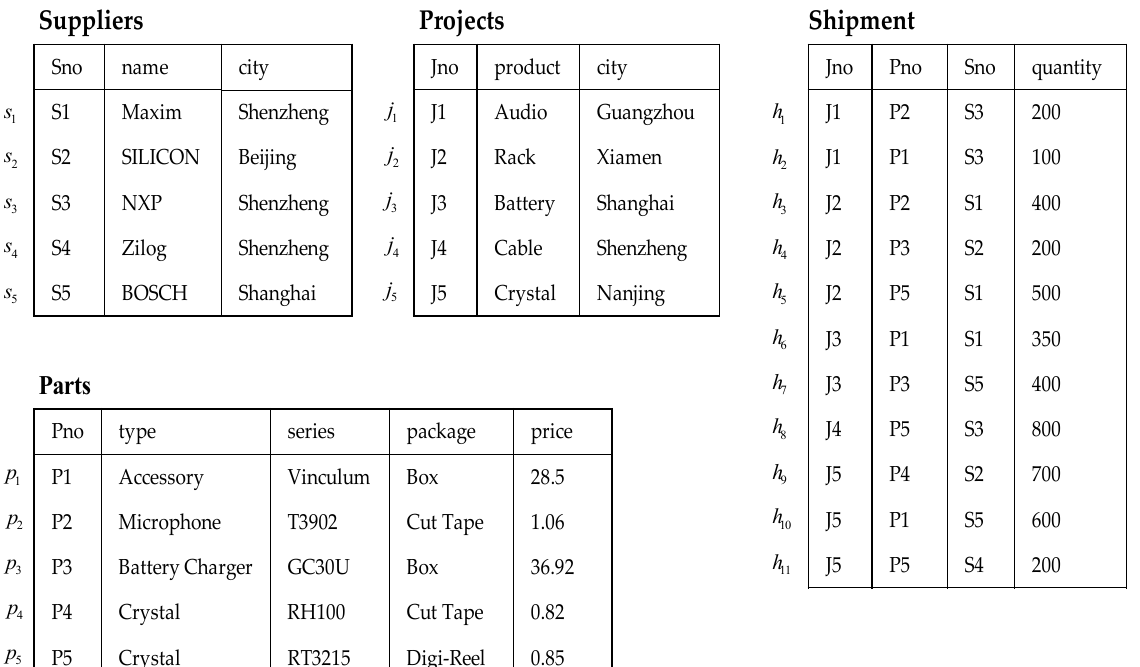
Figure 1. A sample database. Suppliers, parts, and projects are uniquely identified by supplier number (Sno), part number (Pno), and project number (Jno), respectively. The shipment relation stores the number of parts a supplier has supplied for a project, where the primary key is the combination of {Sno, Pno, Jno}.